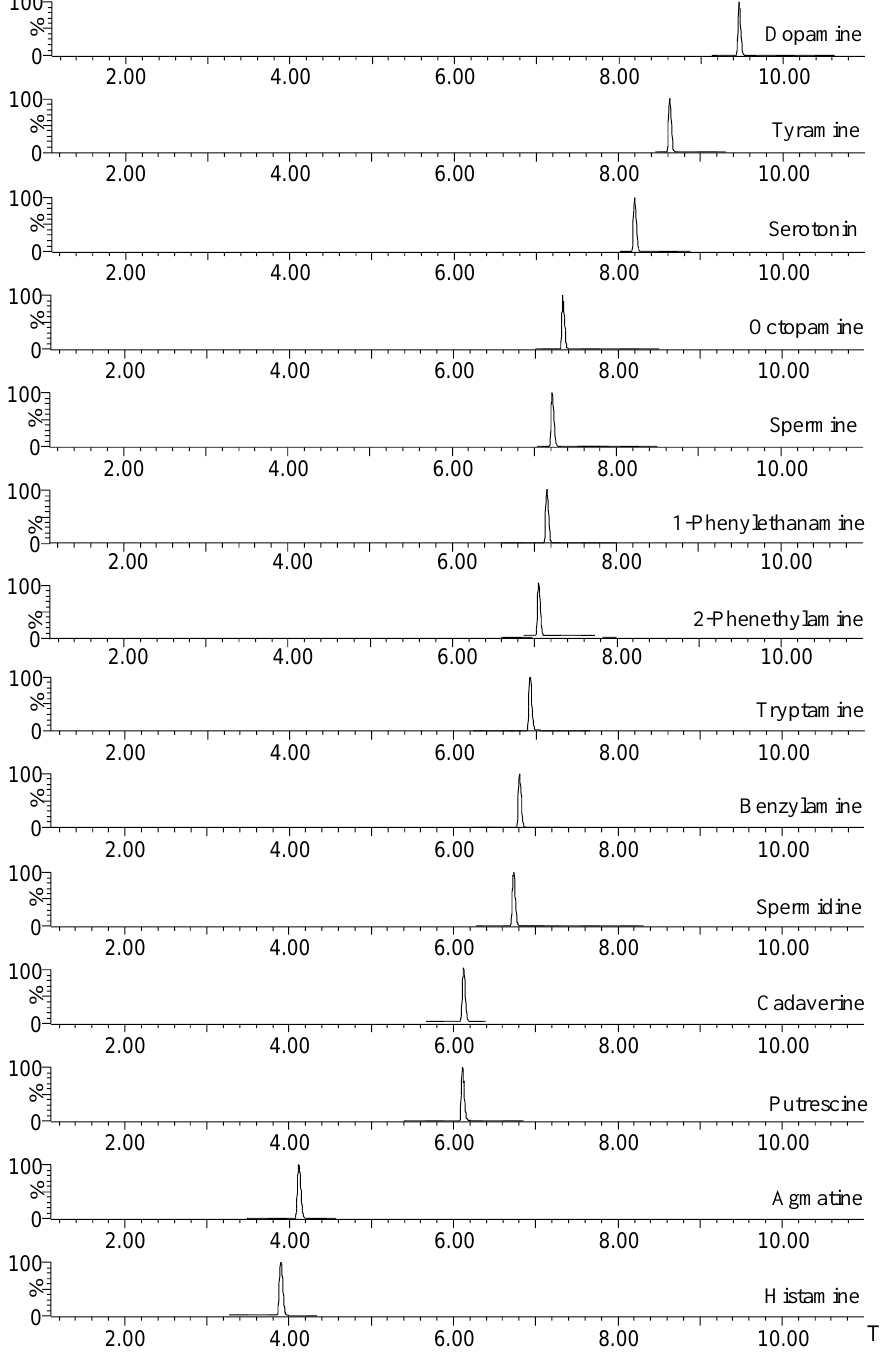
Figure 2. A chromatogram of 14 derivatized BAs in a 1000 nM standard mixture.